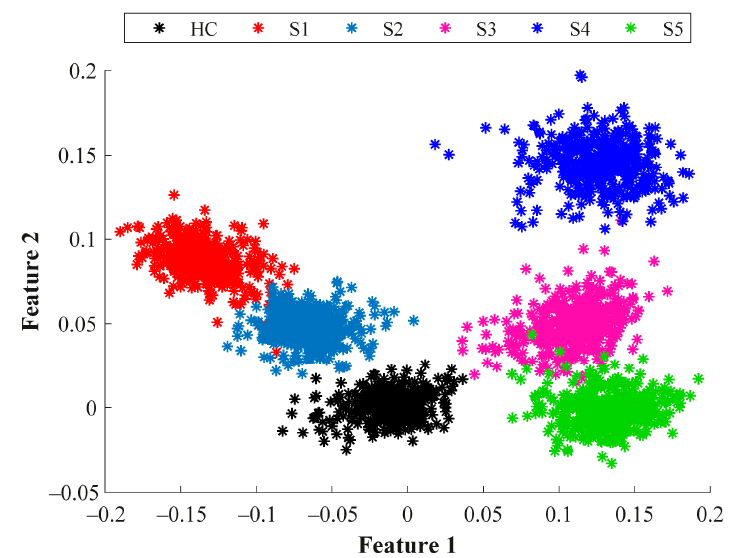
Figure 6. The resulting 2- dimensional LDA projection achieved over all considered conditions, that is, HC, S1, S2, S3, S4, and S5. is, HC, S1, S2, S3, S4, and